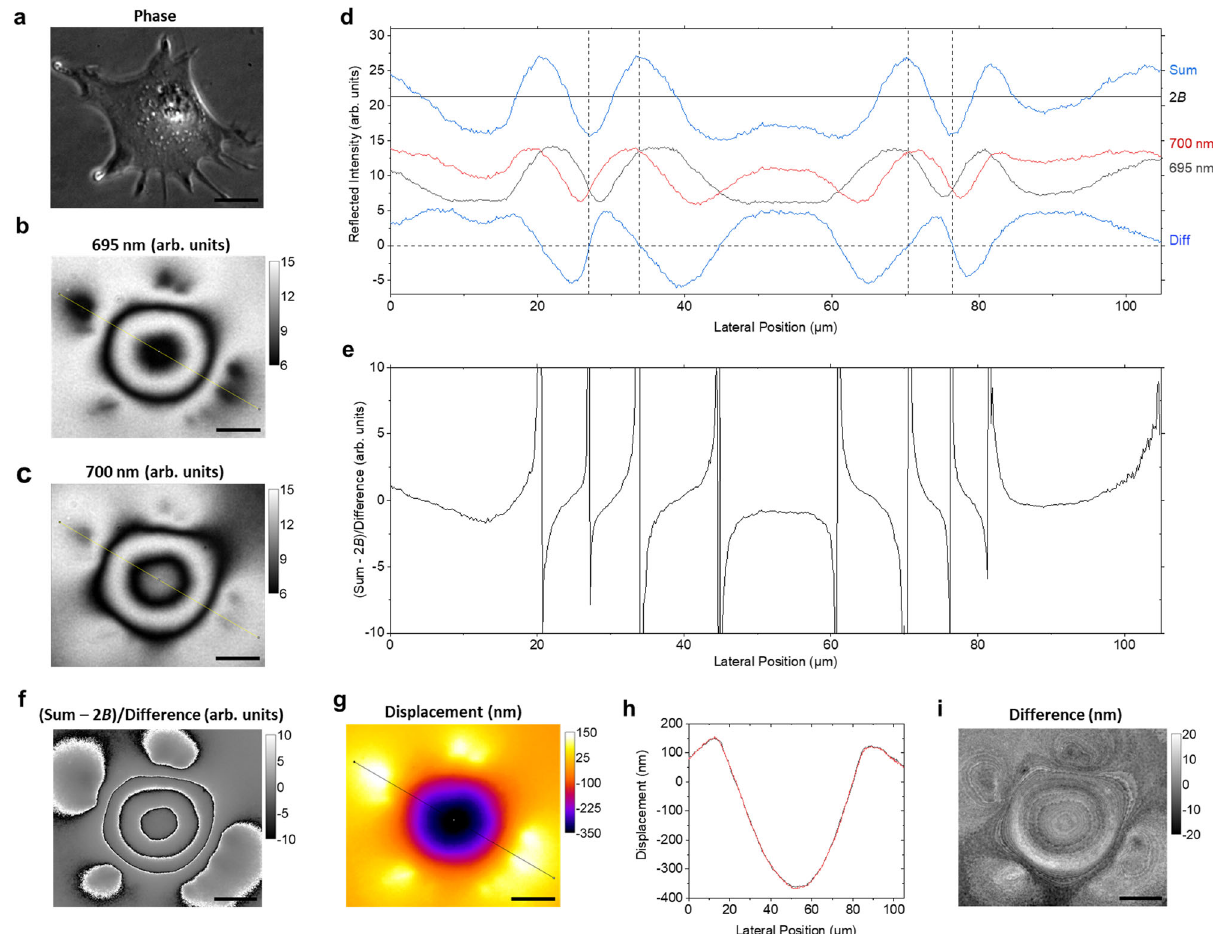
Fig. 2 Testing the accuracy of WARP microscopy for NIH-3T3 cells. a Phase-contrast image of an NIH-3T3 cell. b , c Monochromatic interference images of the same cell at 695 nm and 700 nm, respectively. Greyscale in arbitrary units. d Plot along the yellow line in the monochromatic images in b and c . A plot along the same line for the sum and difference images is also shown, with the match between zero-crossing points and maxima/minima used to establish the background. e Ratio of the sum and difference pro fi le in d , after subtracting the background 2 B from the sum. f Division image corresponding to the pro fi le in e . g Displacement map generated from the division image via automated fringe counting and use of a lookup table. h Pro fi le plot along the black diagonal line in g (black) and pro fi le plot along the same line for a displacement map generated by wavelength-scanning ERISM (red). The black line is mostly hidden behind the red line due to the good agreement between both approaches. i Difference between the displacement map in g and the corresponding displacement map obtained by wavelength-scanning ERISM. Scale bars, 20 µ m. Images are for a representative cell from three independent